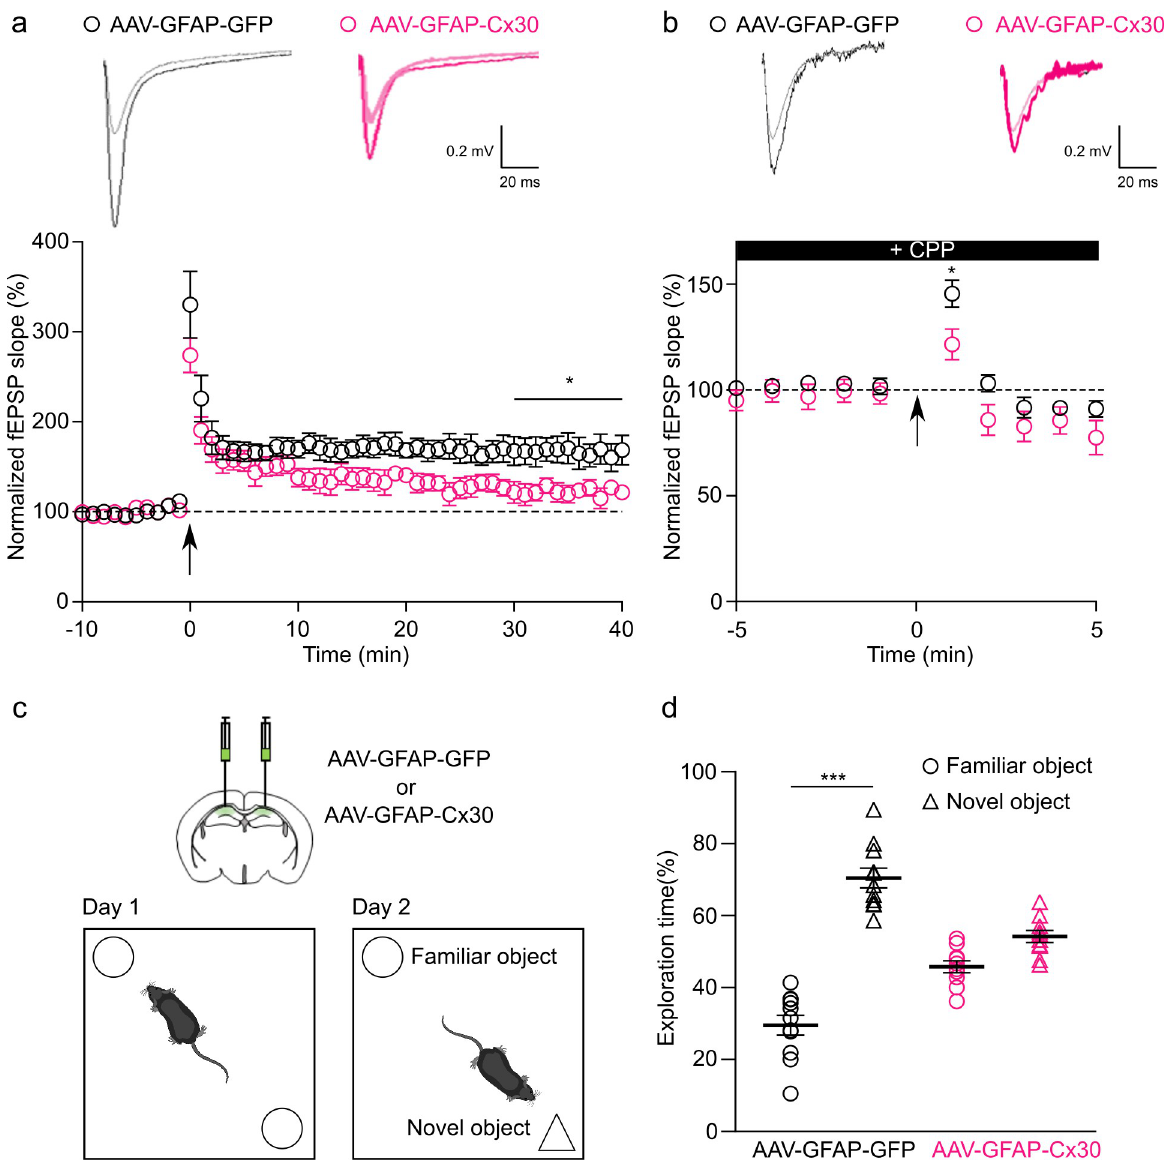
Fig 4. Upregulation of astroglial Cx30 decreased LTP and recognition memory. (a) Tetanus-induced LTP curves (arrow, two 100 Hz tetani for 1 s, interval 20 s) and representative traces. LTP maintenance for the last 10 min (30–40 min) was decreased for AAV-GFAP-Cx30 ( n = 9 slices from 5 mice) compared to AAV-GFAP-GFP ( n = 8 slices from 5 mice); * p < 0.05, Welch’s t test). (b ) Tetanus-induced PTP curves (arrow, two 100 Hz tetani for 1 s, interval 20 s and representative traces under CPP (20 μ M). PTP was decreased for AAV-GFAP-Cx30 ( n = 12 slices from 5 mice) compared to AAV-GFAP-GFP ( n = 12 slices from 5 mice; * p < 0.05, Welch’s t test). ( c) Schematic of NOR memory test after bilateral hippocampal injections of AAV-GFAP-GFP or AAV-GFAP-Cx30 in mice. ( d) Percentage exploration time for familiar versus novel object for AAV-GFAP-GFP ( n = 11 mice) and AAV-GFAP-Cx30 ( n = 10 mice). Individual numerical values are indicated in S1 Data. *** p < 0.001, Kruskal–Wallis multiple comparison test. CPP, 3-(RS)-(2-carboxypiperazin-4-yl)-propyl-1-phosphonic acid; LTP, long-term potentiation; NOR, novel object recognition; PTP, posttetanic